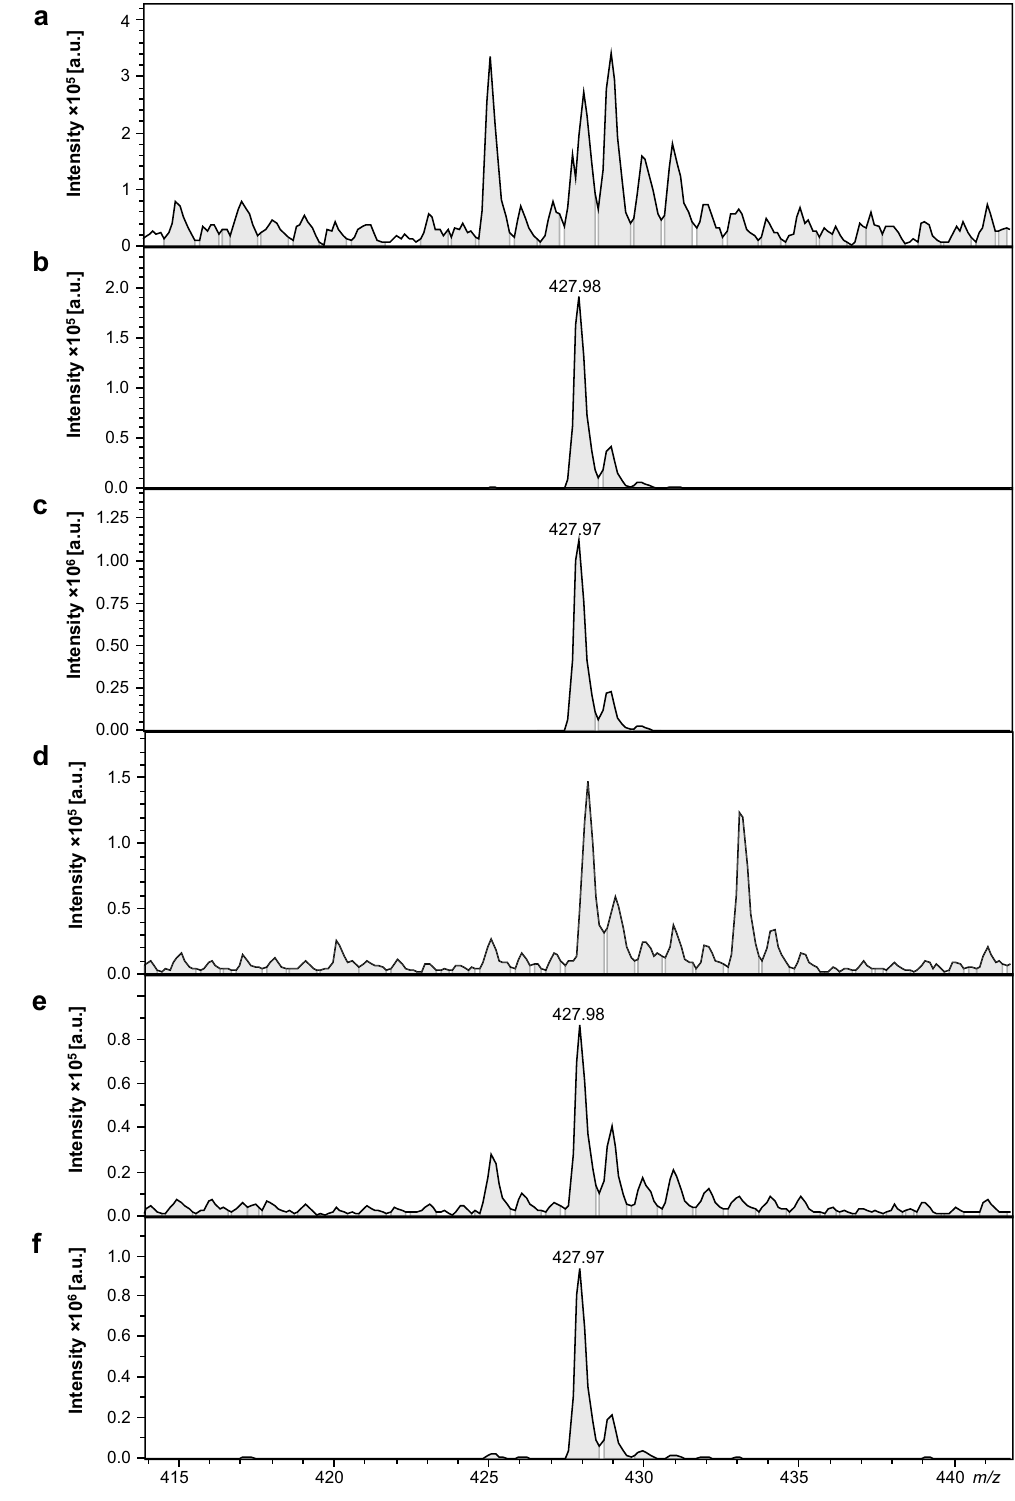
Figure 1. Mass spectra of the blood serum: control ( a ), 25I-NBOMe 1 mg/kg ( b ), 25I-NBOMe 10 mg/kg ( c ) and the frontal cortex analysis: control ( d ), 25I-NBOMe 1 mg/kg ( e ), 25I-NBOMe 10 mg/kg ( f ), indicating the occurrence of the 25I-NBOMe precursor ion (~ 428 m/z); a.u. arbitrary